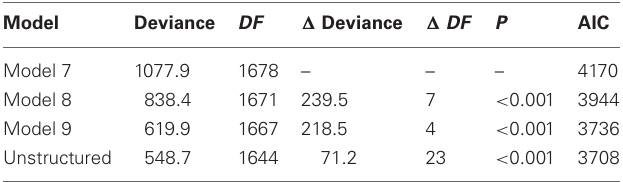
Table 7 | Comparison of the goodness of fit for four different mixed models (models 7 to 9 and the unstructured model), as fitted to CIMMYT maize stress trials.